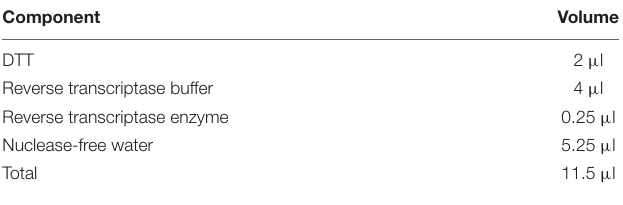
TABLE 8 | cDNA synthesis mix.